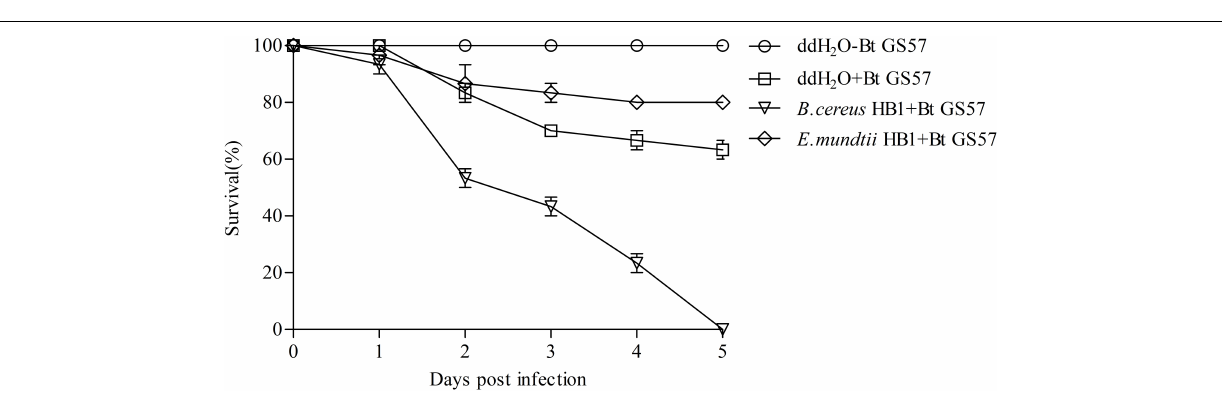
FIGURE 7 | Survival of Spodoptera exigua fed Bacillus cereus and Enterococcus mundtii after infection with Bt GS57. Control S. exigua were fed ddH 2 O. Bacteria were introduced into the 4th instar larvae of S. exigua gut. Introduction of B. cereus ( B. cereus + Bt GS57) significantly increased S. exigua susceptibility to Bt GS57 infection compared with the ddH 2 O + Bt GS57 treatment [log-rank (Mantel-Cox) test, P < 0.01]. The experiments were performed in three biological replicates. The log-rank test was used to assess the significance of differences between two survival curves using GraphPad Prism